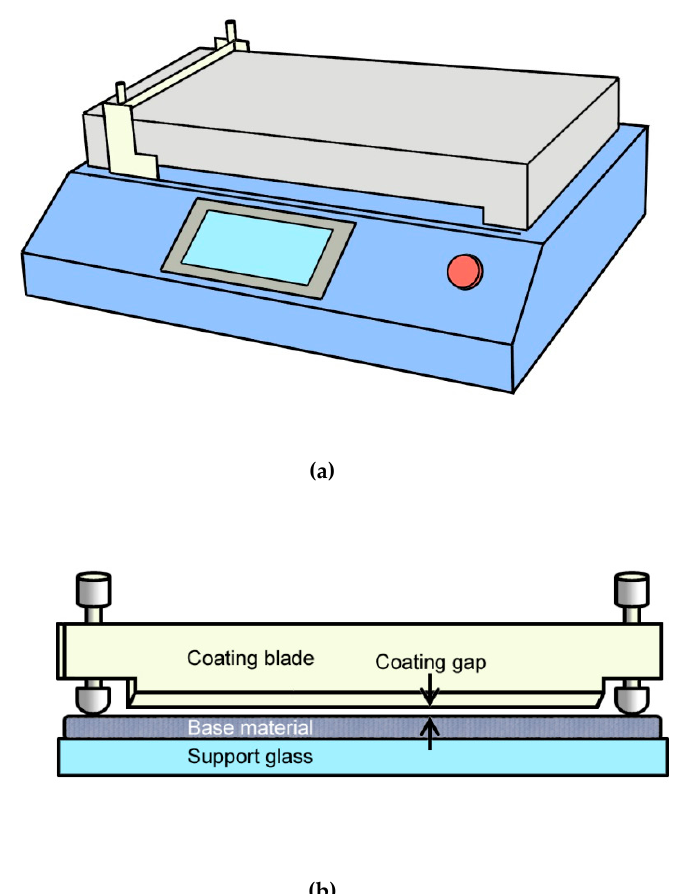
Figure 1. Schematic diagram of fabricating equipment: ( a ) coating machine and ( b ) coating com- ponent ( b